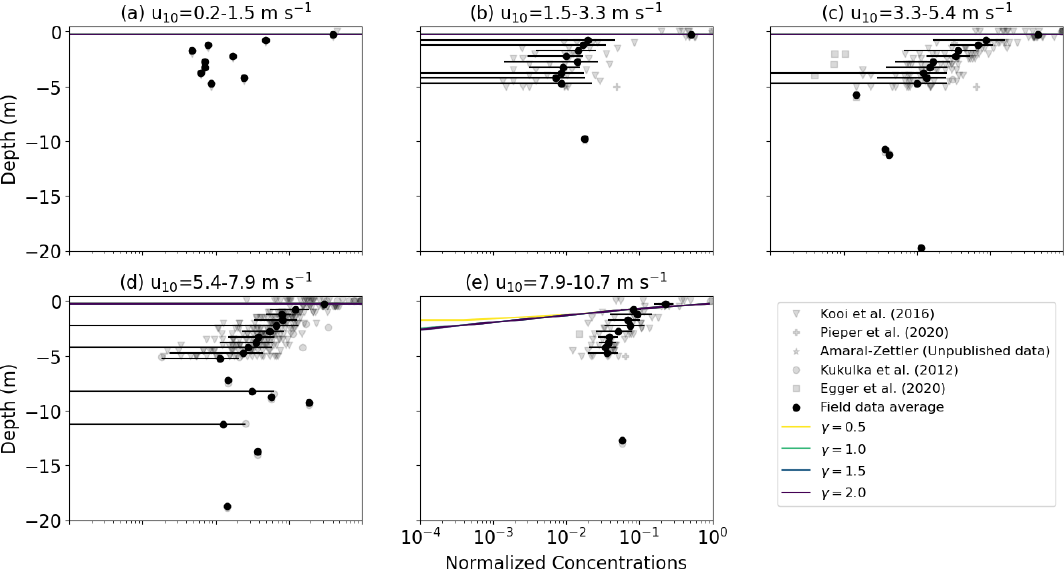
Figure E1. Vertical concentrations of buoyant particles for SWB diffusion under varying wind conditions with w r = 0 . 0003ms − 1 . The SWB diffusion profile is calculated with γ ∈ [ 0 . 5 , 1 . 0 , 1 . 5 , 2 . 0 ] . The grey markers indicate field measurements, with darker shades indicating more measurements, while the binned field measurement average and standard deviation are shown by the black markers. Shading around the profiles indicates the profile’s standard deviation at each depth